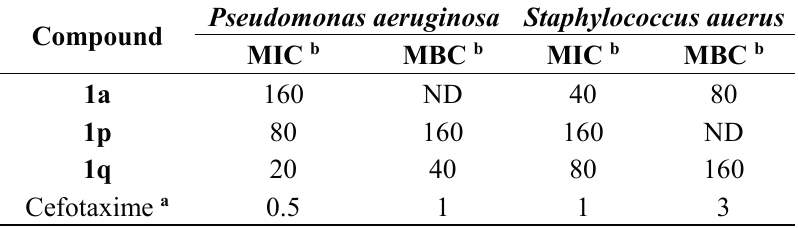
Table 2. Antibacterial activity of chromone-tetrazoles and fluorine-containing chromone-tetrazoles against pathogenic bacterial strains.